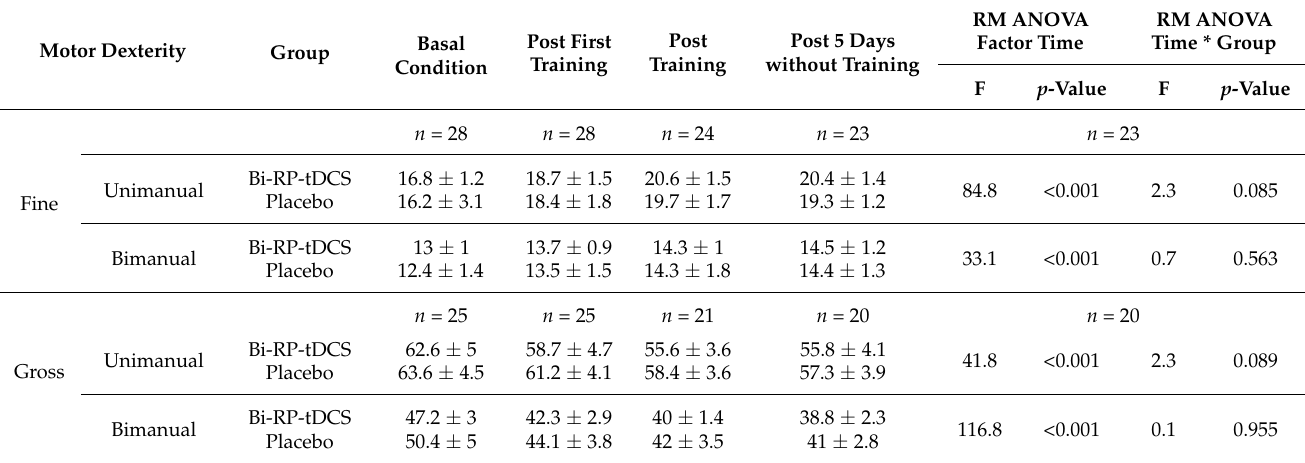
Table 2. Motor learning during bi-RP-tDCS (mean ±